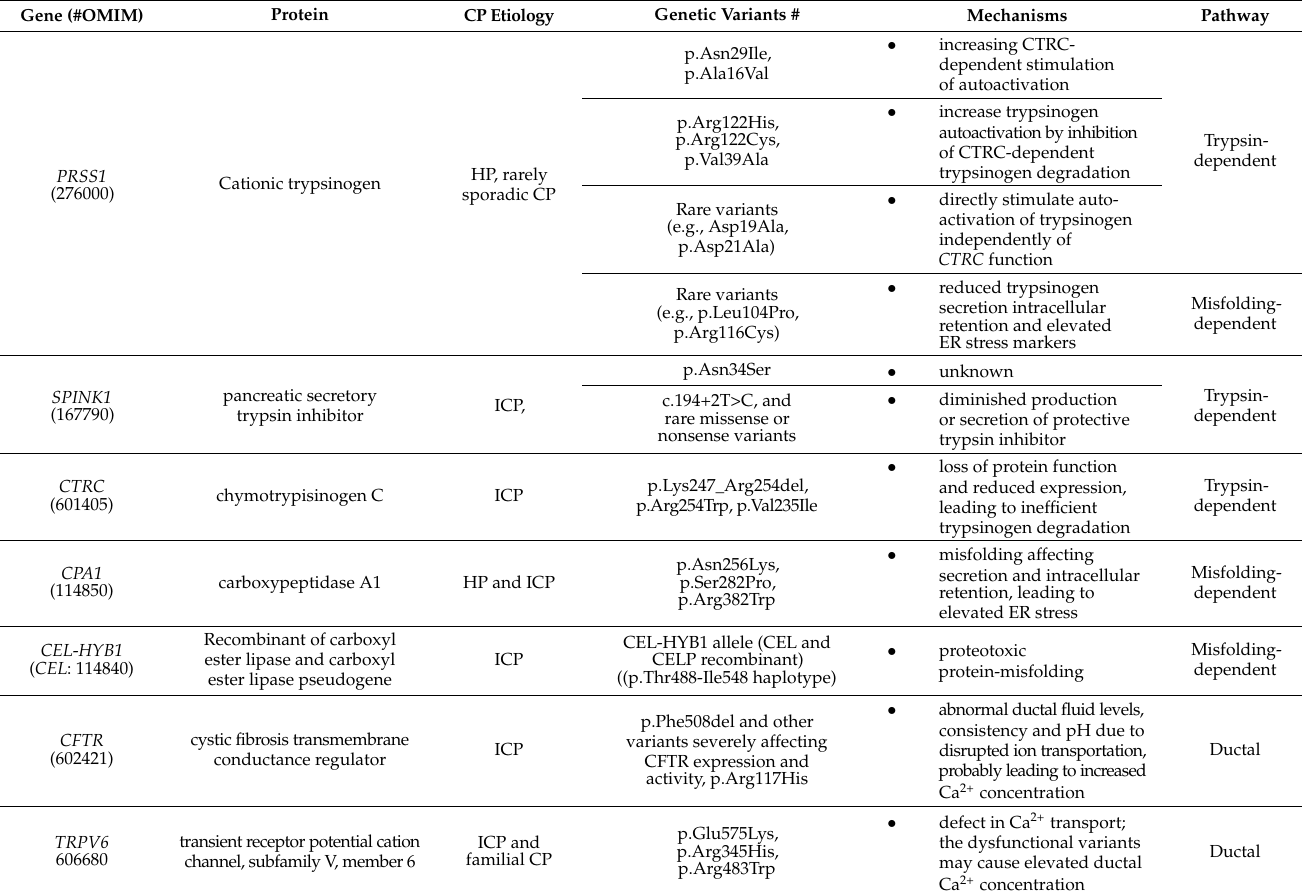
Table 1. Pathways associated with genetic variants involved in chronic pancreatitis